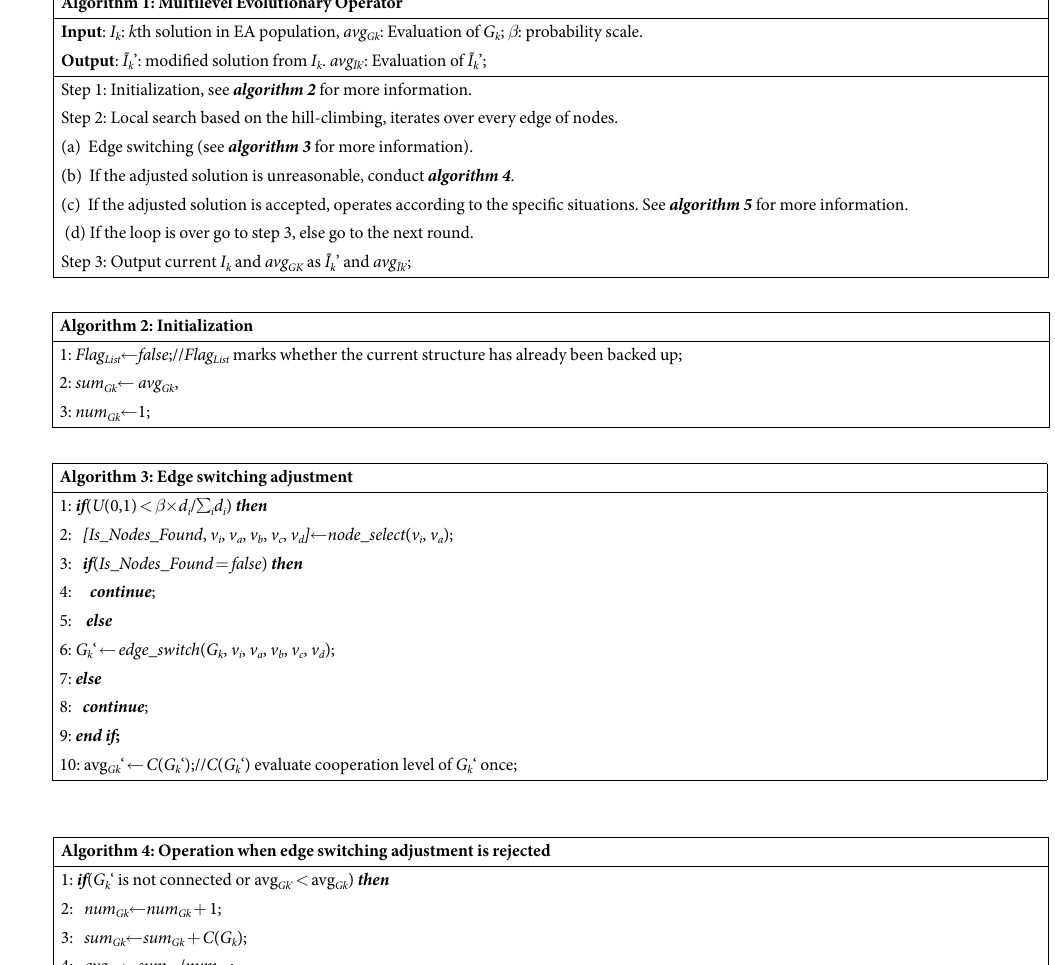
Algorithm 1 Provide details of the multi-level evolutionary operator and β marks the probability scale. Algorithm 1: Multilevel Evolutionary Operator